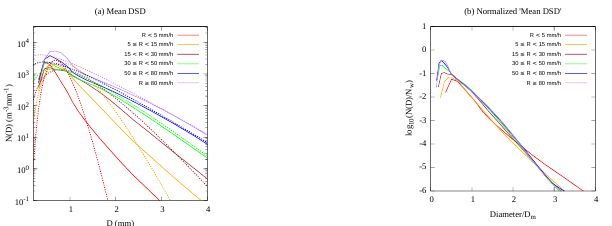
Figure 4. ( a ) Mean DSDs for six rain rates categories: less than 5 mm h − 1 (red solid line), 5 ≤ R < 15 mm h − 1 (orange), 15 ≤ R < 30mm h − 1 (brown), 30 ≤ R < 50mm h − 1 (green), 50 ≤ R < 80mm h − 1 (blue), and R ≤ 80mm h − 1 (purple), respectively. The dotted lines are the estimated gamma distributions that are based on the mean DSD parameters ( D m , N w , µ ) of each rain rate category listed in Table 1. ( b ) Normalized ’mean DSDs’ by use of N w and D m .The meaning of the colored solid lines is same as ( a ).